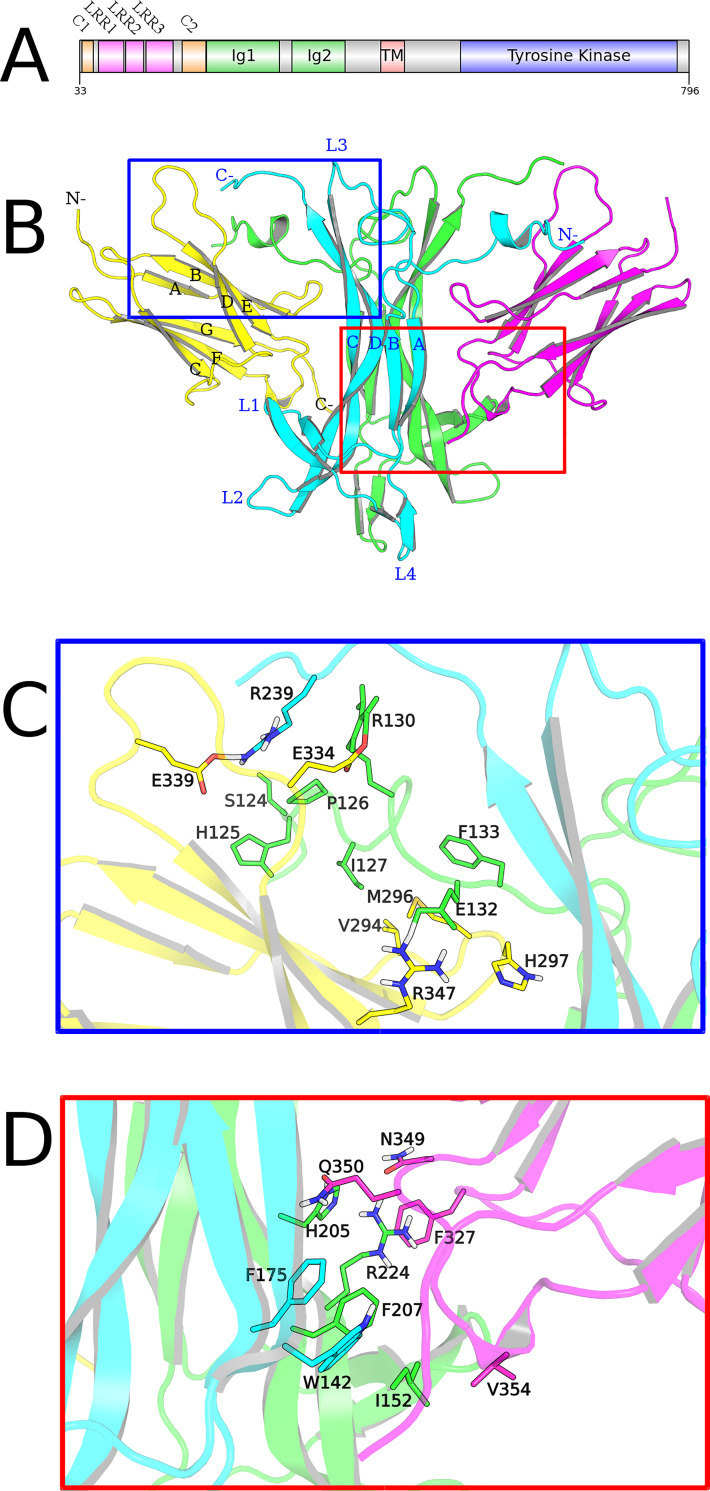
NGF/TrkA-Ig2 complex and binding sites.(A) Domain organization of TrkA. Domains are colored in: orange, cysteine-rich clusters (C1-2); in magenta, leucine-rich repetitions (LRR1-3); in green, immunoglobulin-like domains (Ig1-2); in red, transmembrane portion (TM); and in blue, tyrosine kinase domain. (B) NGF/TrkA-Ig2 complex motif description. (C) Specific and (D) conserved NGF/TrkA epitopes. Chains are colored as: NGFA, green; NGFB: cyan; TrkAA: magenta; TrkAB: yellow.